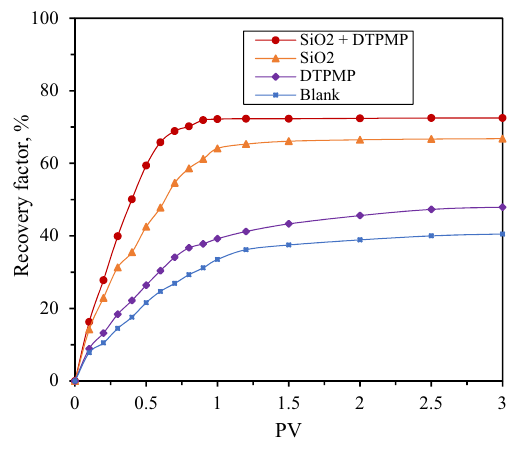
Fig. 8 The changes in recovery factor during LSWI in the presence and absence of DTPMP and SiO 2 -nanoparticles at different pore vol- umes